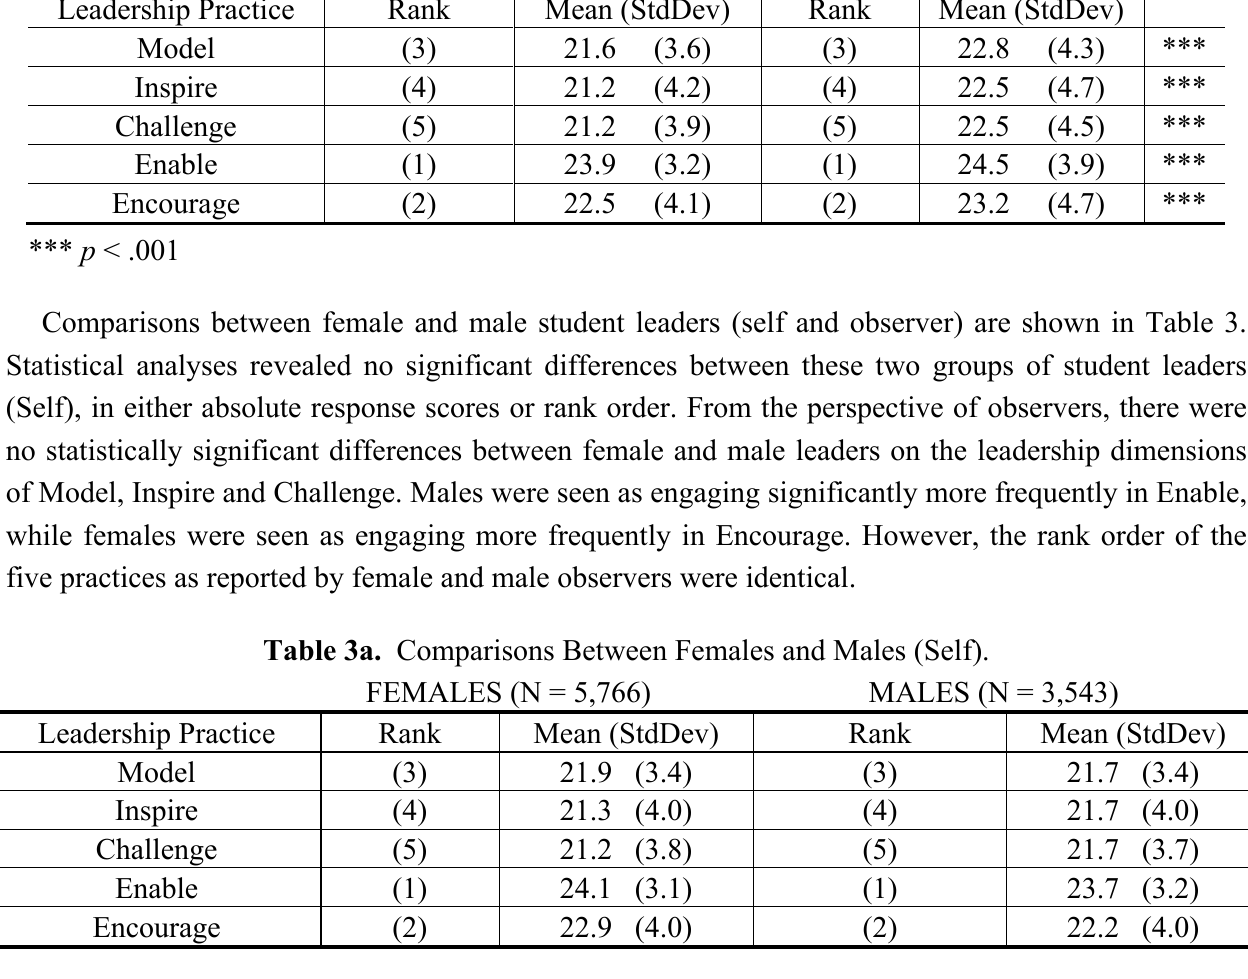
Table 3b. Comparisons Between Females and Males